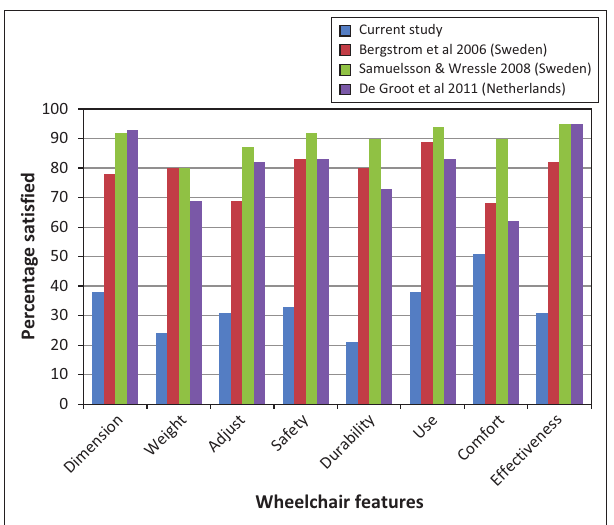
FIGURE 5: Comparison of QUEST 2.0 wheelchair feature item scores across four